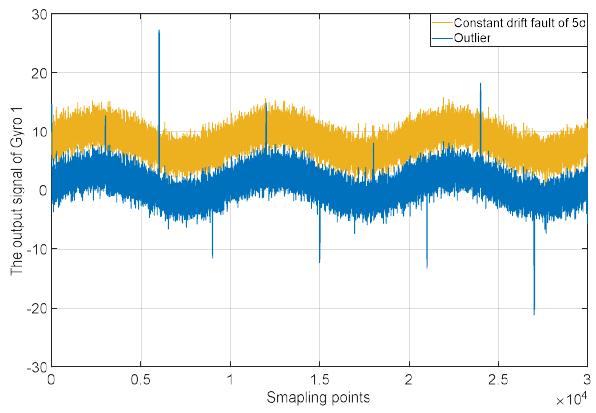
Figure 11. Two kinds of anomaly signals.